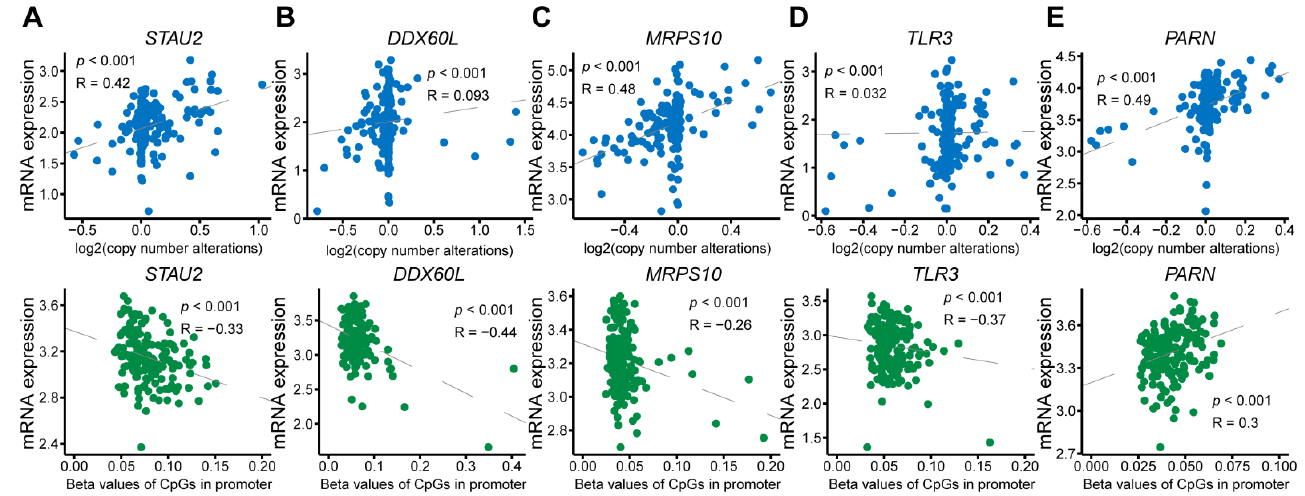
Figure 3. Upstream regulation of alternated hub RBPs in PAAD patients. Top scatter plots showed the relationship between mRNA expression and copy number alterations in ( A ) STAU2 , ( B ) DDX60L , ( C ) MRPS , and ( D ) TLR3 . ( E ) The bottom scatterplot of PARN shows the relationship between mRNA expression and promoter DNA methylation levels in ( A ) STAU2 , ( B ) DDX60L , ( C ) MRPS , ( D ) TLR3 , and ( E ) PARN .